Question: Sum up the contents of this chart in one sentence.
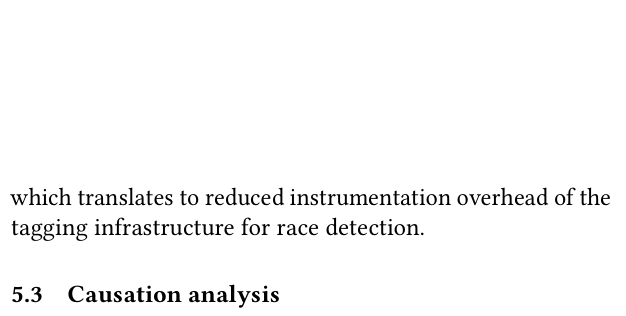
Answer: provides insight into the overhead of the HMTRace framework with variance in the number of shared allocations, 𝑅𝐷/𝑊𝑅thread counts, number of pointers, and acquired locksets. We use DRB075 [33] as the baseline microbench- mark and introduce the necessary variations in its dataset to obtain causal insights. HMTRace applies similar instru- mentation to both 𝑅𝐷and 𝑊𝑅segments, incurring similar processor and memory overhead penalties with varying num- bers of 𝑅𝐷/𝑊𝑅counts. HMTRace does not observe consid- erable variance in overhead when increasing the number of pointers, as higher overhead instrumentations such as lock- set updates and checks are performed only during segment start, with subsequent updates to pointer address incurring a minimal tag update overhead (same order as a volatile mem- ory write). HMTRace only incurs memory overhead when increasing the number of pointees, as it has to align and pad these allocations while tracing lockset information for each pointee. HMTRa